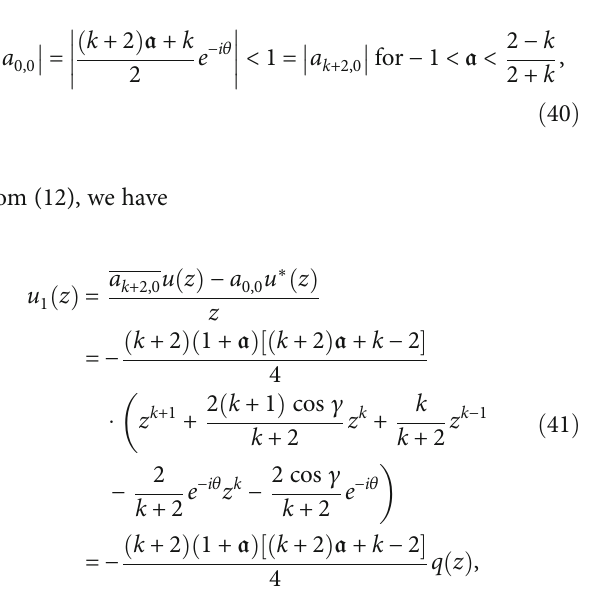
Figure 3: Image of P